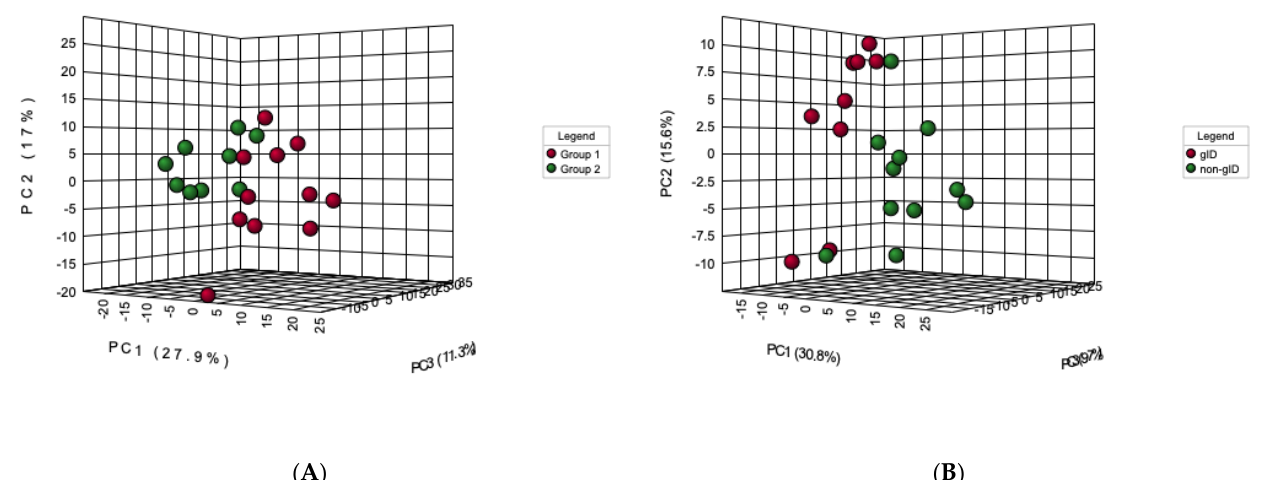
Figure 1. 3D − PCA score plots of urine samples from gID fed animals (red spheres) and non − gID fed animals (green spheres). This analysis shows data from negative ( A ) and positive ( B ) ion modes. This separation was also clearly observed in supervised PLS − DA plots (Supplementary Figure S1).